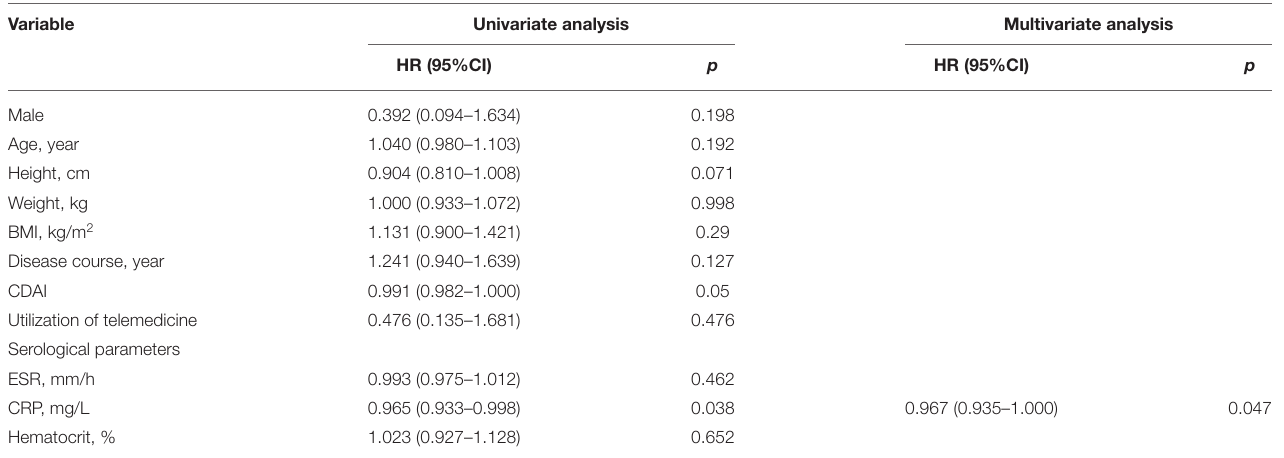
TABLE 2 | Univariable and multivariable analyses of risk factors of delayed treatment.